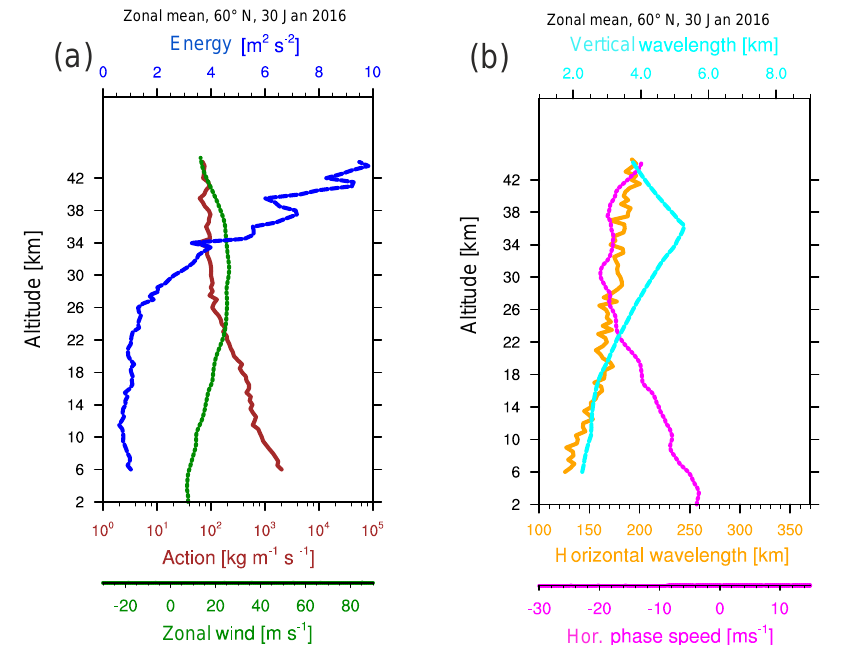
Figure 3. Zonal mean profiles at 60 ◦ N with (a) zonal wind (green, dotted), energy (dark blue, dashed), and wave action (red, solid) and (b) apparent horizontal phase speed (pink, dotted), vertical wavelength (light blue, dashed), and horizontal wavelength (orange, solid).